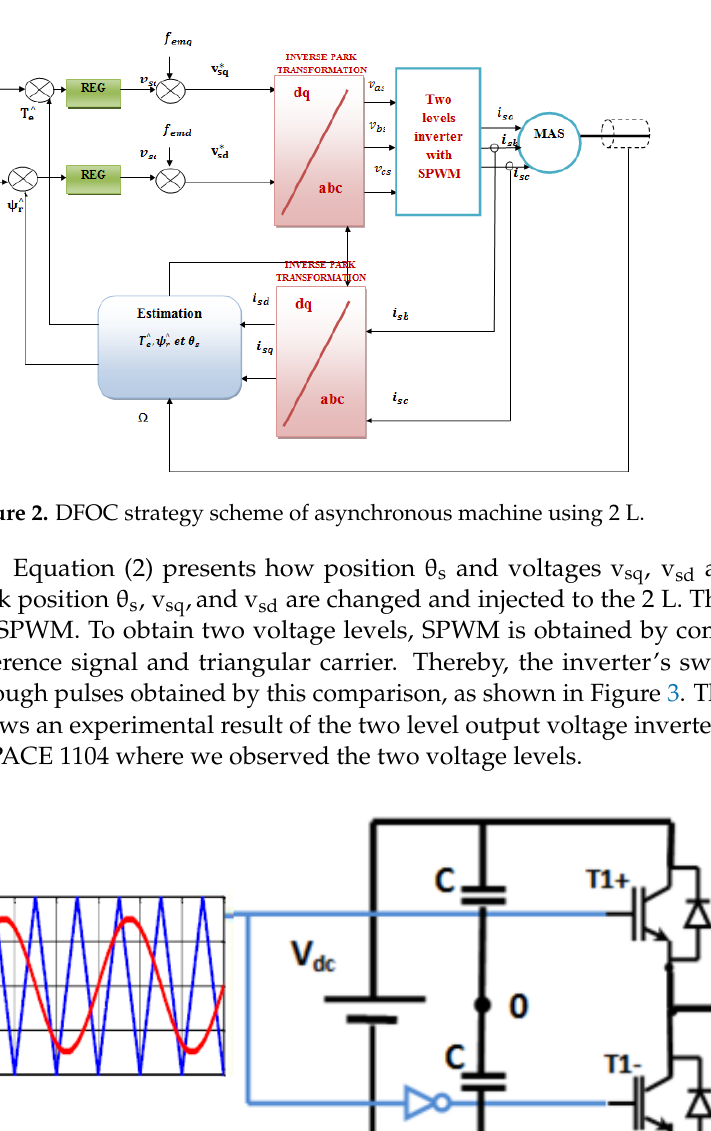
Figure 2. DFOC strategy scheme of asynchronous machine using 2 L.